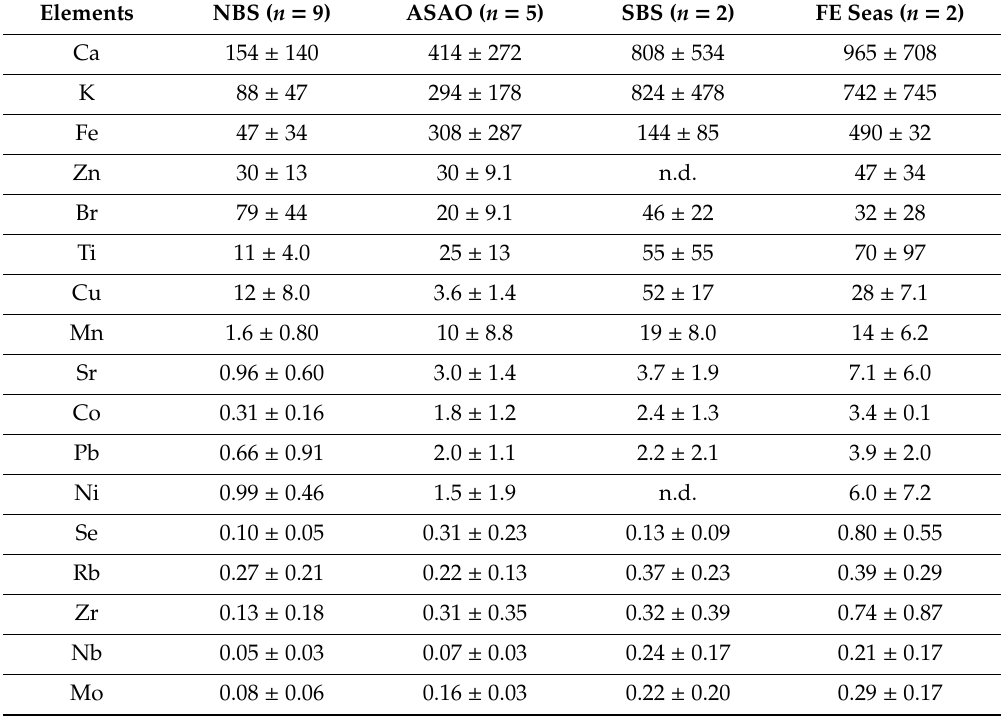
Average ( ± SD) concentrations of elements in aerosol composition (ng / m 3 ) during “TransArctic–2019” expeditions ( n is the number of